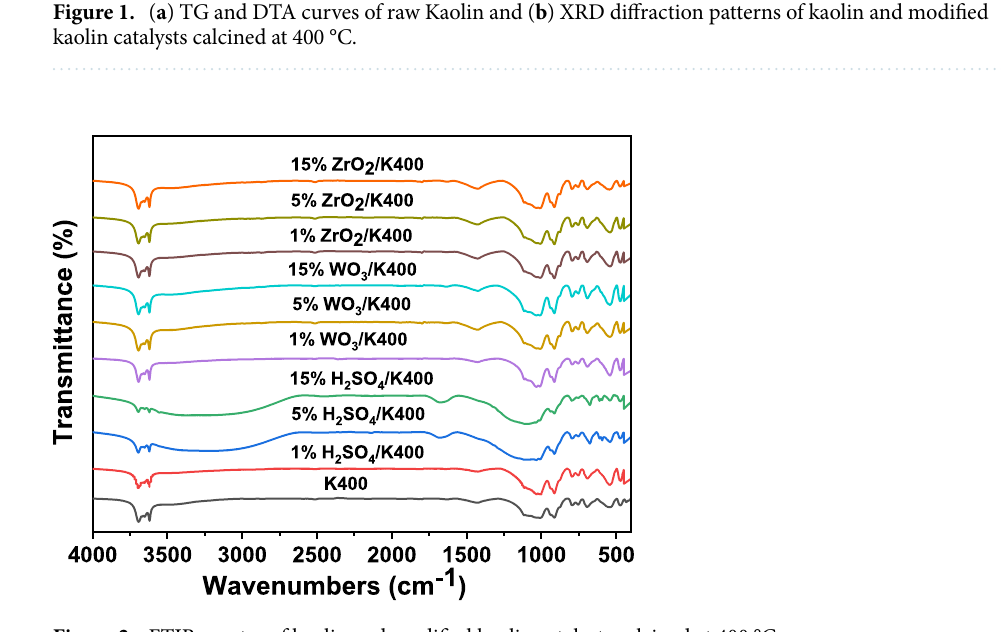
Figure 2. FTIR spectra of kaolin and modified kaolin catalysts calcined at 400